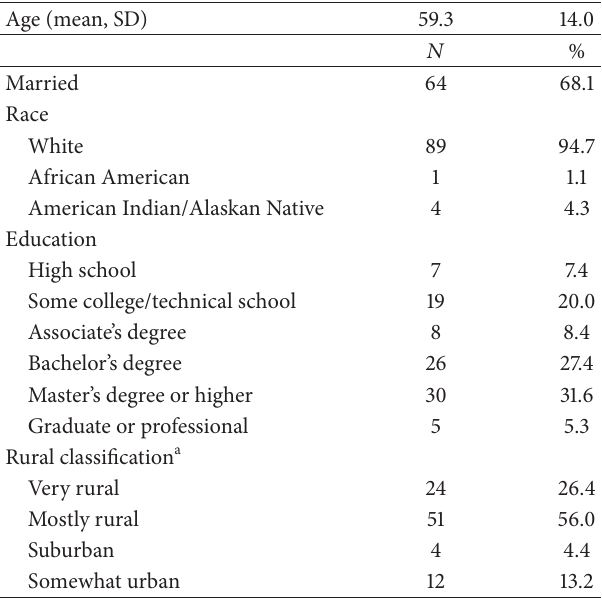
Table 2: Demographic characteristics of focus group participants ( 𝑁 = 95 ).